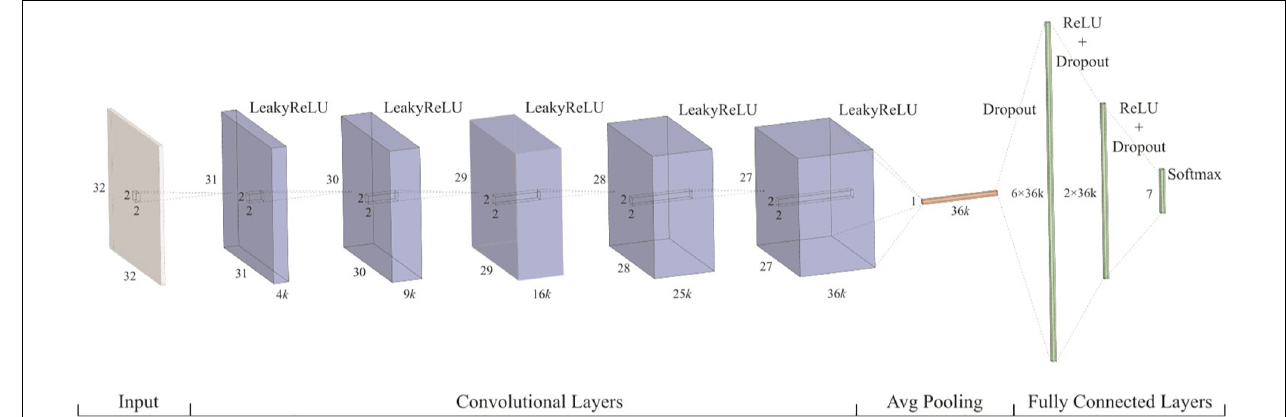
FIGURE 5 | Convolutional neural network.